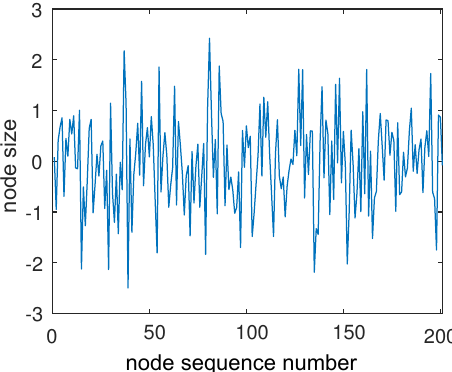
Figure 3. Nodes in Gaussian